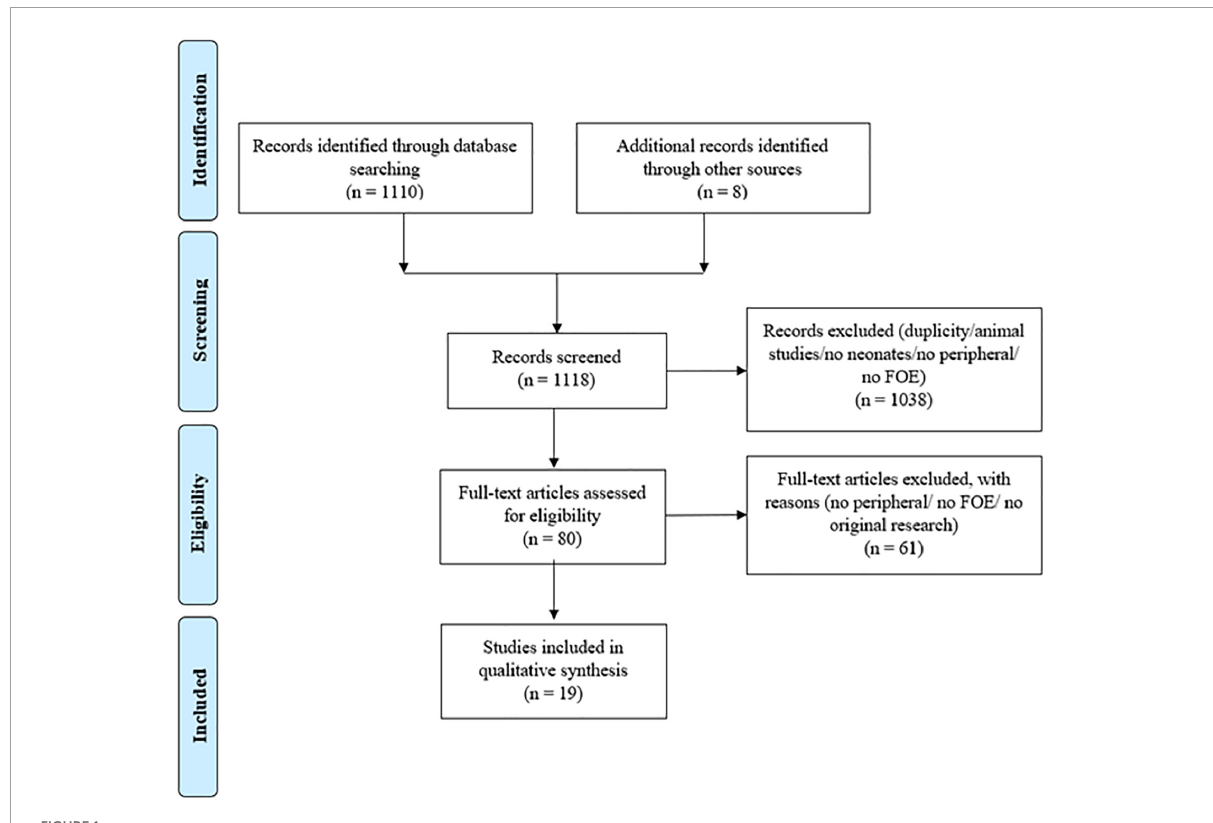
FIGURE1 PRISMA flow